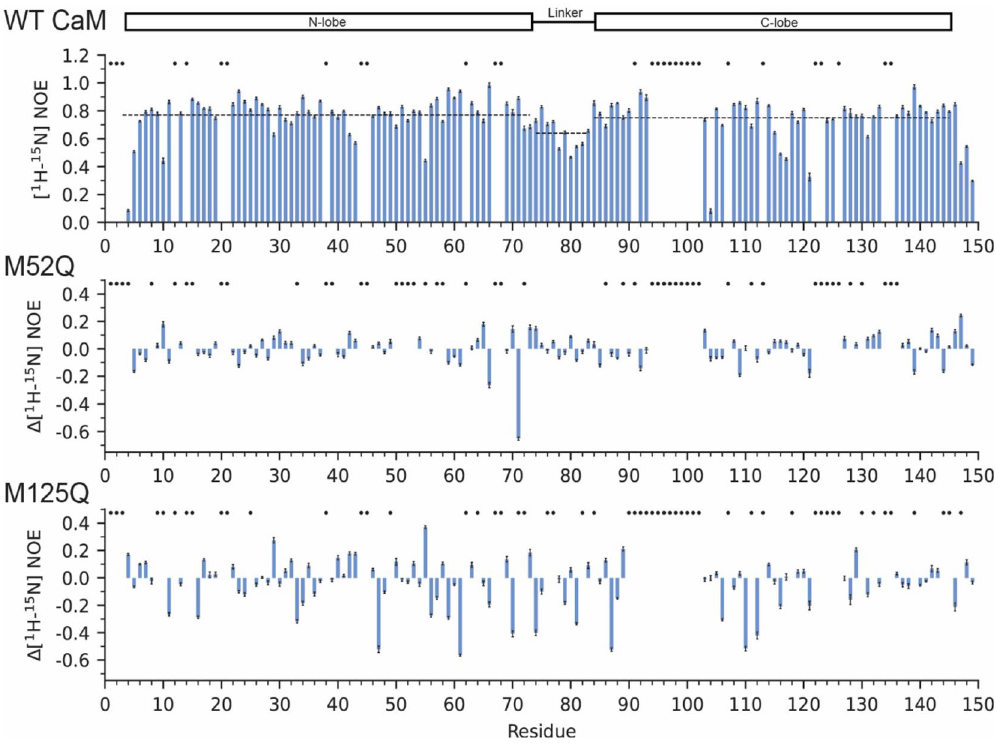
Figure 4. [ 1 H, 15 N] Backbone NOE values in the presence of saturating Ca 2+ . [ 1 H, 15 N] backbone heteronuclear NOE values for WT CaM in the presence of 6 mM CaCl 2 (top). Relative differences in NOEs for M52Q-CaM, and M125Q-CaM are shown in the lower panels. NOE values for each residue were determined by taking the ratio between the peak intensities of the saturated and unsaturated spectra. Error bars represent the uncertainty in each NOE value, determined relative to the baseline noise level in the saturated and unsaturated spectra. Dashed lines indicate the average NOE of each domain. NMR Spectra were analyzed using NMRFAM-Sparky 46